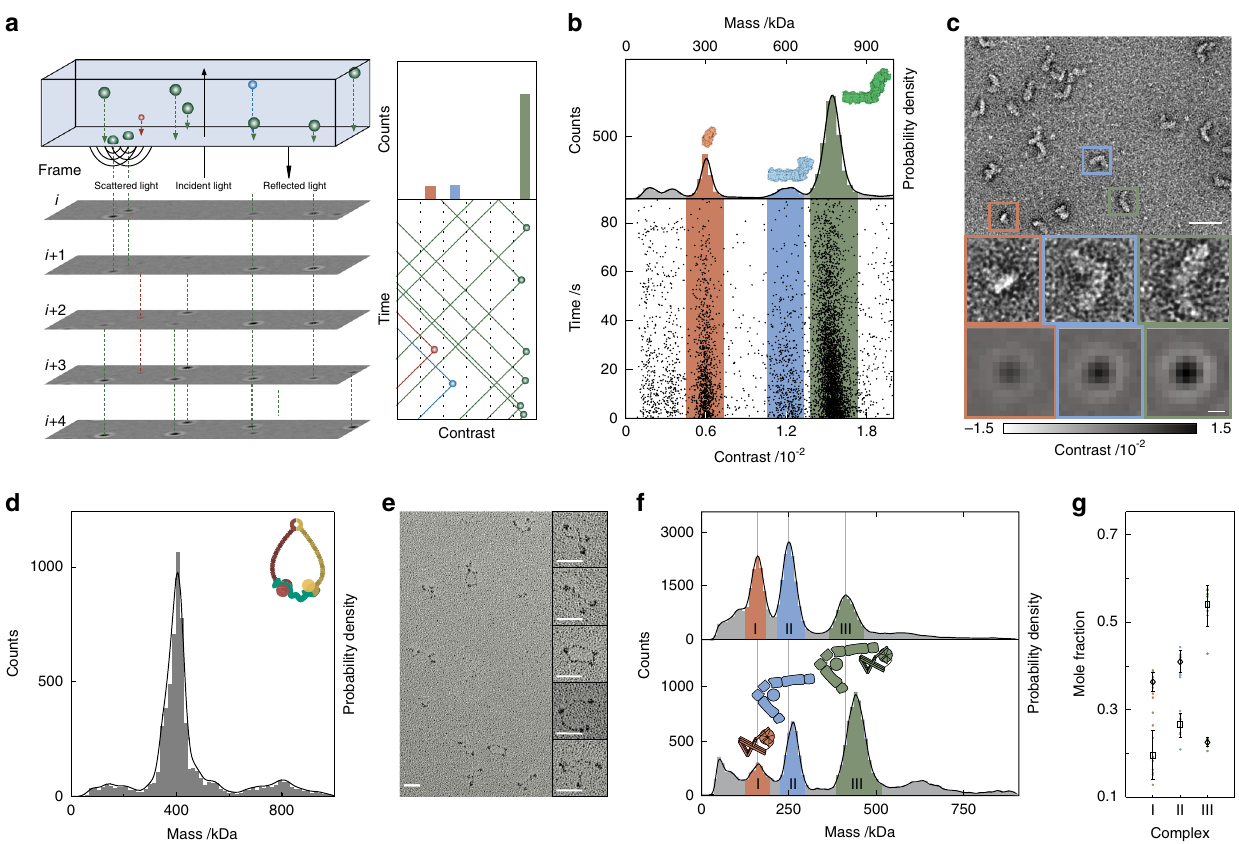
Fig. 1 Mass photometry as a general method for characterizing biomolecular heterogeneity. a Principle of operation based on interference between scattered and re fl ected light combined with ratiometric imaging. b Scatter plot of binding events for NADH:ubiquinone oxidoreductase (respiratory complex I, 12.5 nM), and the corresponding mass histogram. c Negative-stain micrograph of the same sample with individual species corresponding to the peaks in b highlighted. MP images of species with the respective mass are shown for comparison. Scale bars: 50 nm (nsEM) and 200 nm (MP). d Mass distribution for 21 nM trimeric cohesin; upper right, cartoon of trimeric cohesin. e Rotary shadowing EM micrograph of trimeric cohesin shows intrinsic conformational fl exibility. Scale bars: 50 nm. f A mixture of two interacting NPC-I and II subcomplexes before (top) and after (bottom) chemical crosslinking with 0.1% glutaraldehyde for 5 minutes followed by quenching. g Reproducibility of the crosslinking procedure shown in f in terms of mole fractions of the three main species before (diamonds) and after crosslinking (rectangles). Source data are provided as a Source Data fi